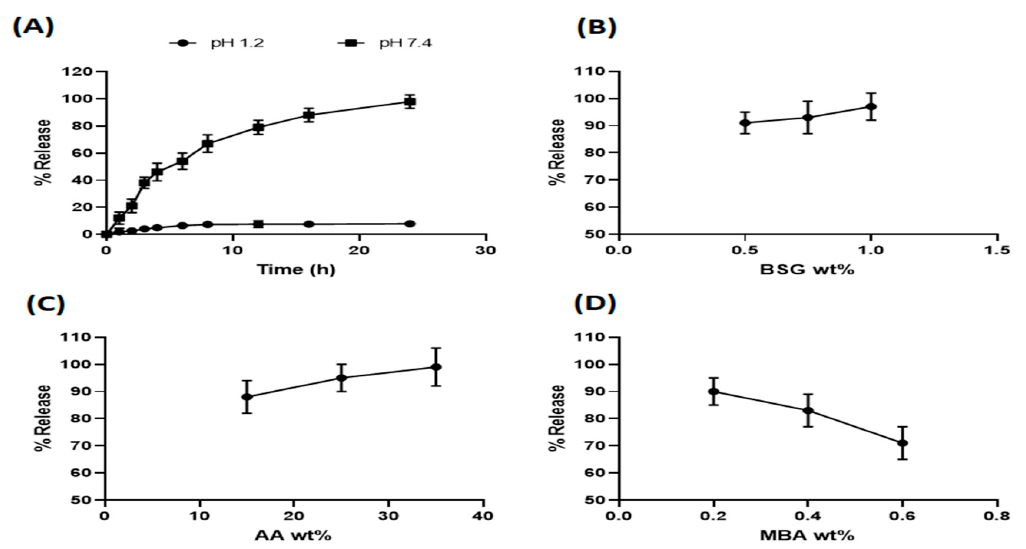
Figure 10. Effect of ( A ) BSG; ( B ) AA; ( C ) MBA on drug loading of hydrogel.